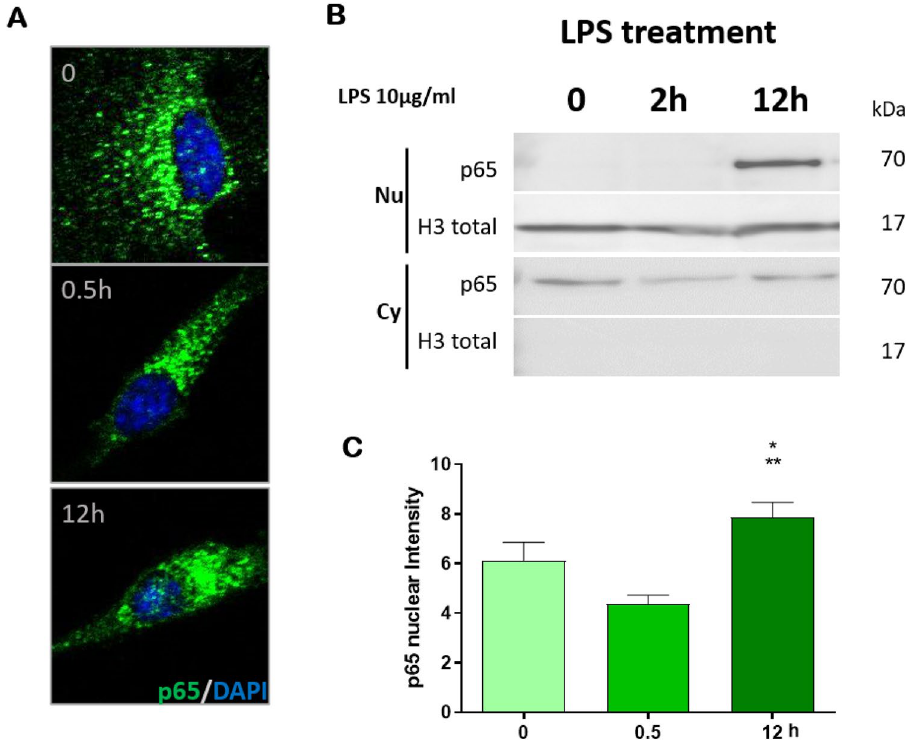
Figure 2. Translocation of the p65 subunit of NF-kB to the nucleus of U87MG cells after LPS treatment. ( A ) Immunofluorescence confocal images at three different time points (0, 0.5, 12 h) of U87MG cells treated with Western blot analysis of p65 with nuclear (Nu) and cytoplasmic (Cy) extracts of U87MG cells after 2 and 12 h of LPS treatment. Histone H3 was used as a loading control for nuclear extract. ( C ) Quantification of